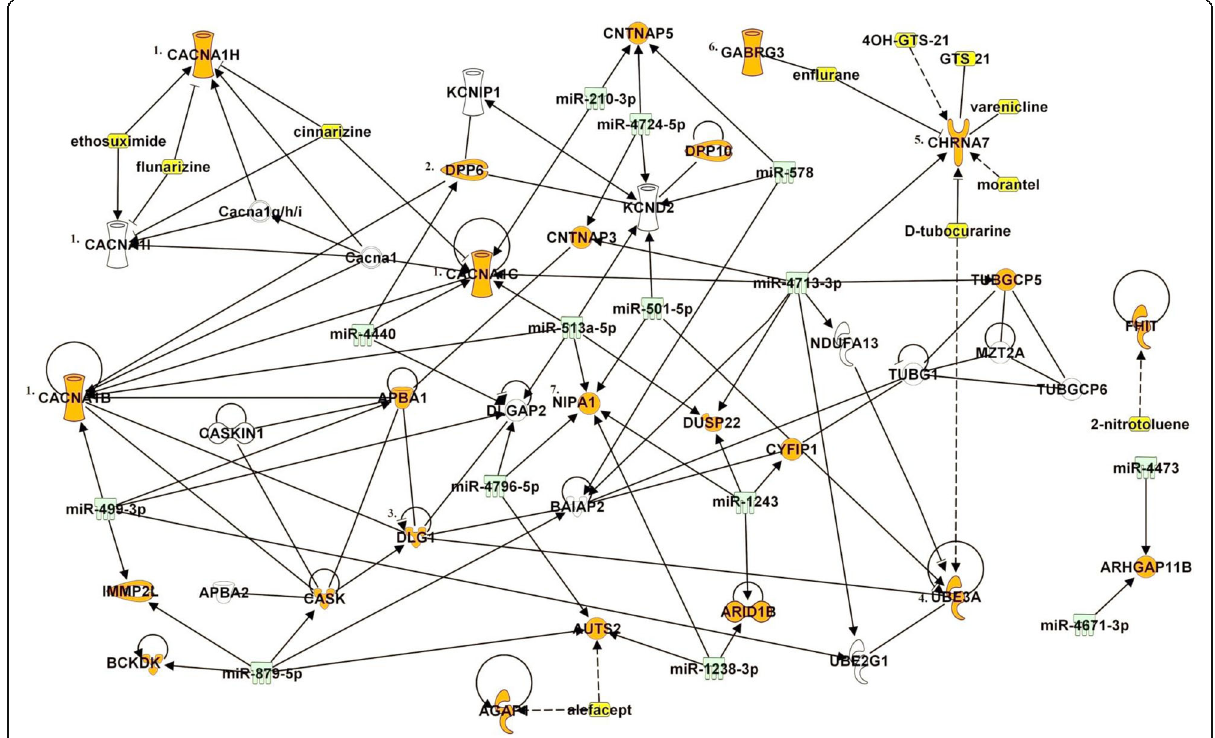
Fig. 3 Ingenuity pathway analysis of enriched autism genes under CNVs. The major hubs in the pathway included the genes CACNA1 , DPP6 , CHRNA7 , GABRG3 , and NIPA1 . This pathway was built from a list of prevalent 25 causal genes in study populations. This pathway has been divided into seven sub-pathways: 1) 4 clusters of CACNA1 genes consisting of CACNA1H, CACNA1C , CACNA1B , and CACNA1I calcium channel signalling. 2) DPP6 is a single-pass type II membrane protein and a member of the peptidase S9B family of serine proteases. It is involved in the physiological processes of brain function and may modulate the cell surface expression and the activity of the potassium channel KCND2 . 3) DLG1 is a multi- domain scaffolding protein, which is required for healthy development. It has a role in septate junction formation, signal transduction, cell proliferation, synaptogenesis, and lymphocyte activation. 4) UBE3A functions, both as an E3 ligase in the ubiquitin-proteasome pathway and as a transcriptional co-activator. 5) CHRNA7 belongs to ligand-gated ion channels mediating fast signal transmission at synapses. The protein encoded by the gene forms a homo-oligomeric channel and displays marked permeability to calcium ions. 6) GABRG3 is the major inhibitory neurotransmitter in the vertebrate brain. It mediates neuronal inhibition by binding to the GABA/benzodiazepine receptor, leading to opening an integral chloride channel. This protein is a gamma subunit, which contains the benzodiazepine binding site. GABRG3 is strongly implicated in autism pathogenesis. It is involved in the inhibition of excitatory neural pathways and expression in early development. 7) NIPA1 encodes magnesium transporter associated with early endosomes and the cell surface in different neuronal and epithelial cells. This protein plays a role